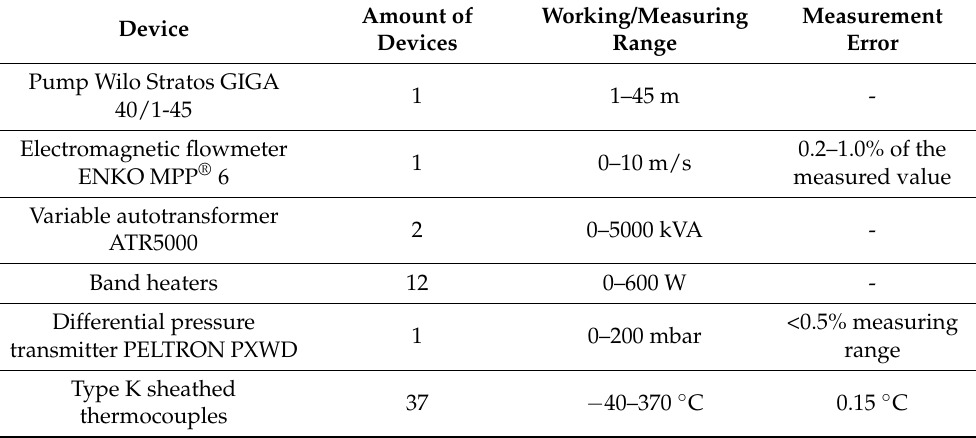
Table 1. Parameters of the elements of the experimental stand.